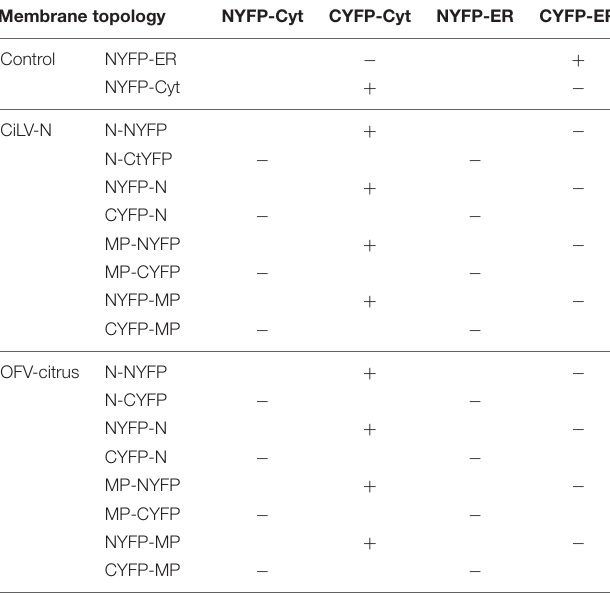
TABLE 1 | Protein pair combinations performed in the BiFC topology assay for MPs and Ns proteins of the CiLV-N and OFV-citrus. Membrane topology